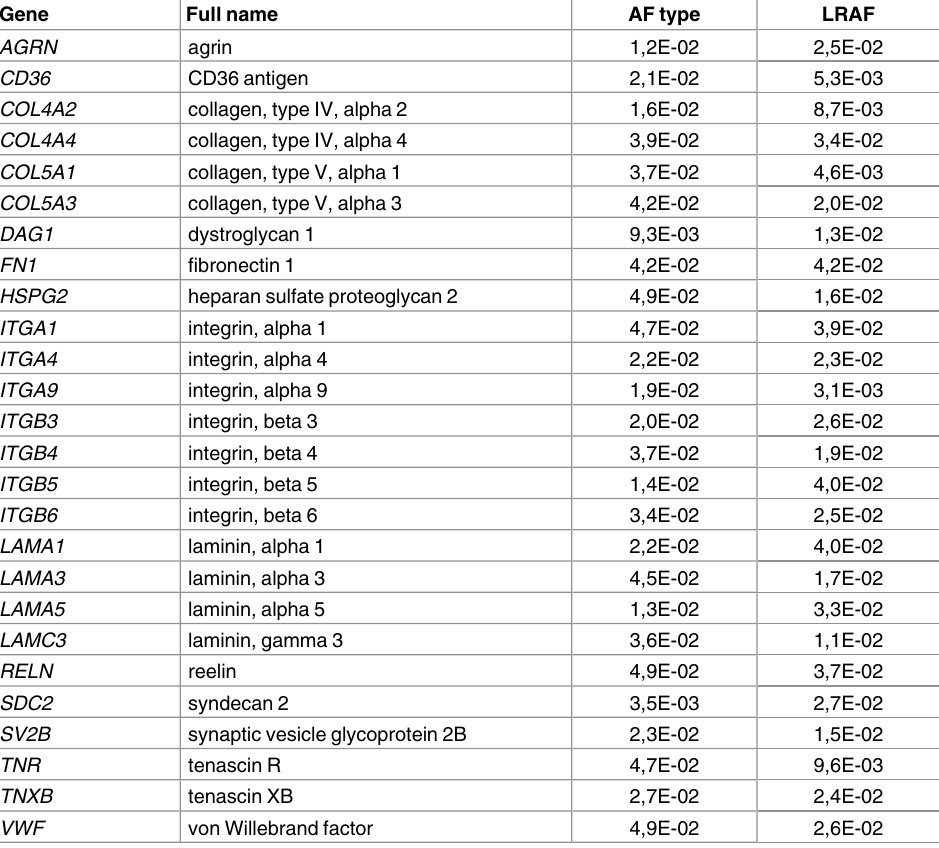
Table 4. Genes of the ECM-receptor interaction pathway associated with AF type and LRAF (in alpha- betical order).